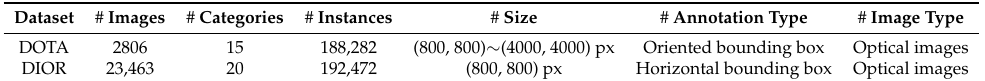
Table 1. The basic information of DOTA and DIOR